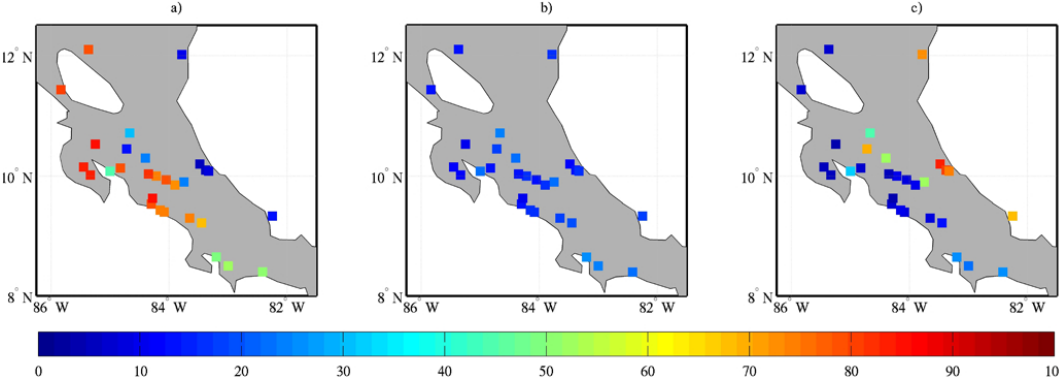
Fig. 9. CCA precipitation forecasts for ASO 2010 accumulates (ACM) using July SST as predictor. Forecast probability maps are for the categories (a) Above, (b) Normal, (c) Below.